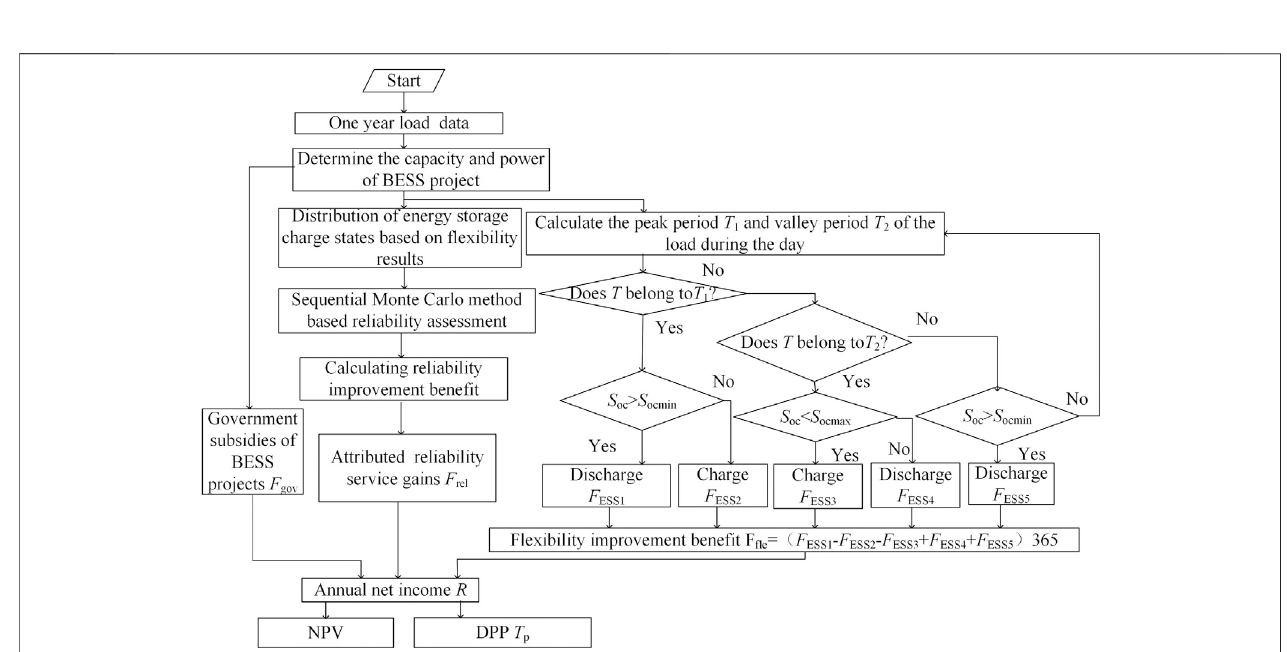
FIGURE 2 | Economic evaluation process of BESS considering its fl exibility and reliability values.